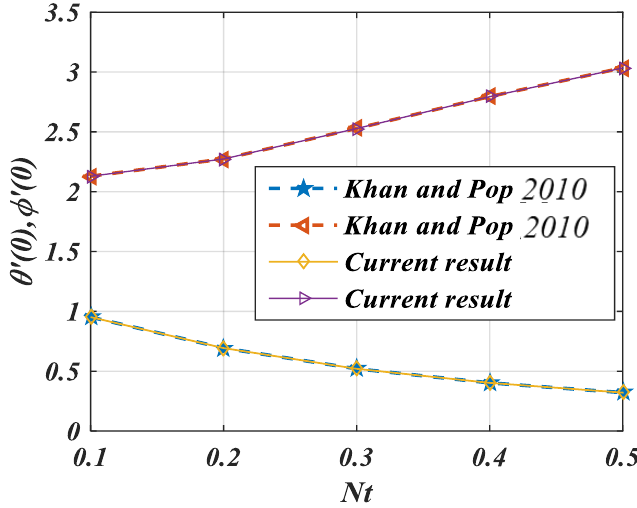
Figure 14. Comparison of Khan and Pop [5] and current result.